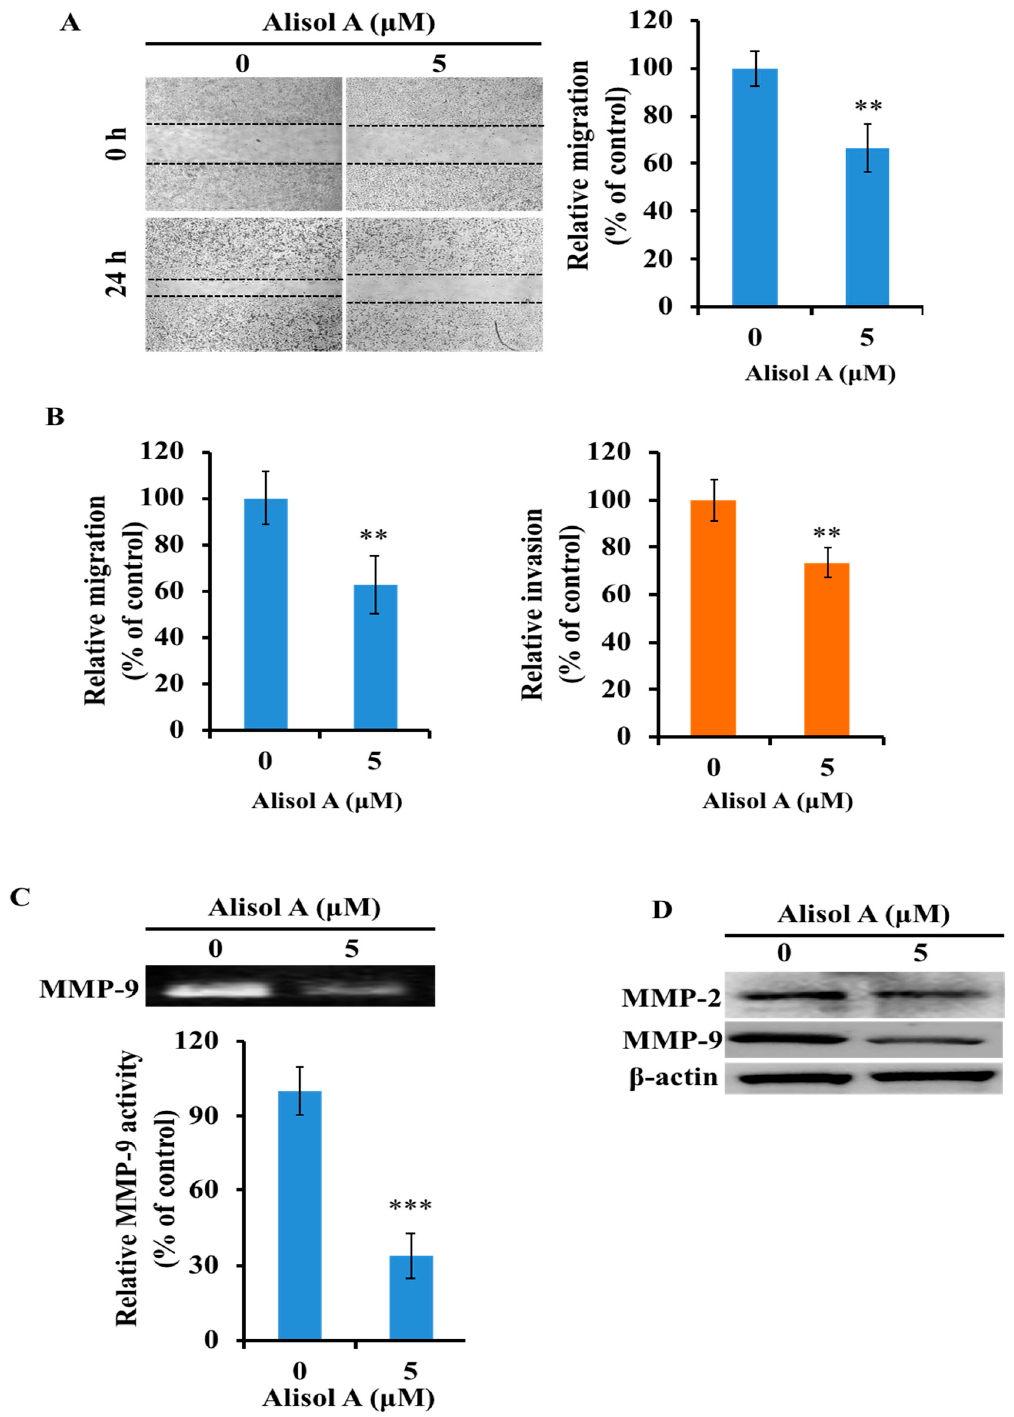
Figure 7. E ff ects of alisol A on cell migration and invasion. ( A ) The e ff ects of alisol A on cell migration was measured by wound healing assay. ( B ) Transwell migration (left) and invasion (right) assay was used to evaluate the in vitro anti-metastatic e ff ects of alisol A. ( C ) E ff ects of alisol A on MMP-9 activity by gelatin zymography assay. ( D ) E ff ects of alisol A on MMP-2 and MMP-9 protein expression in MDA-MB-231 cells. Data are presented as the mean ± S.D of three independent experiments. ** p < 0.01, *** p < 0.001.